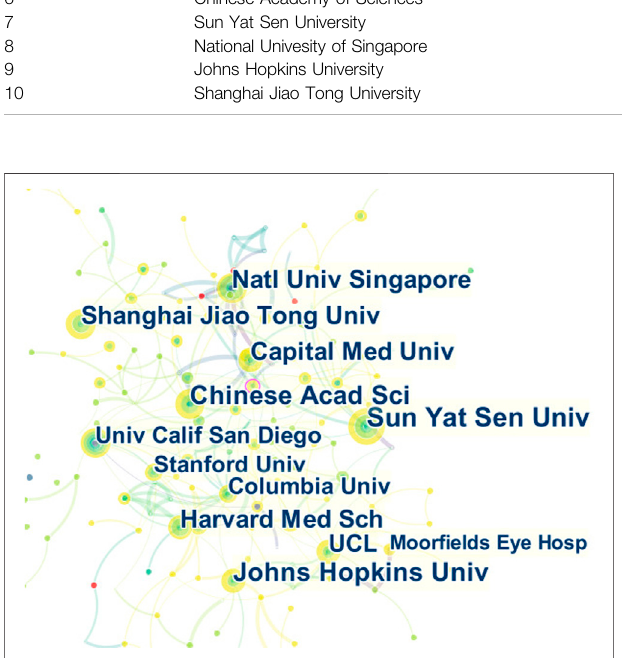
FIGURE 4 | Cooperation of institutions that contributed to publications on the use of AI in the diagnosis of ophthalmic diseases from 2012 to 2021.